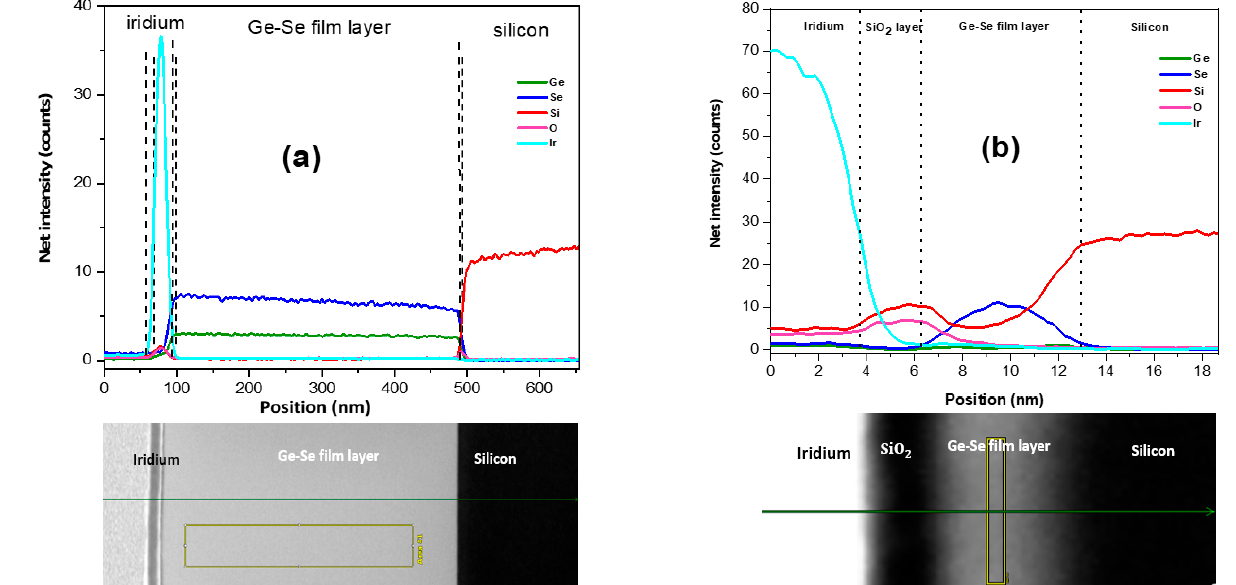
Figure 4. STEM images of GeSe 4 thin film, SiO 2 , and silicon layers (bottom). EDX line scans for Ge, Se, Si, O, and Ir, were obtained along the indicated lines shown on the STEM images ( a ) 25 °C and ( b ) 600 °C.